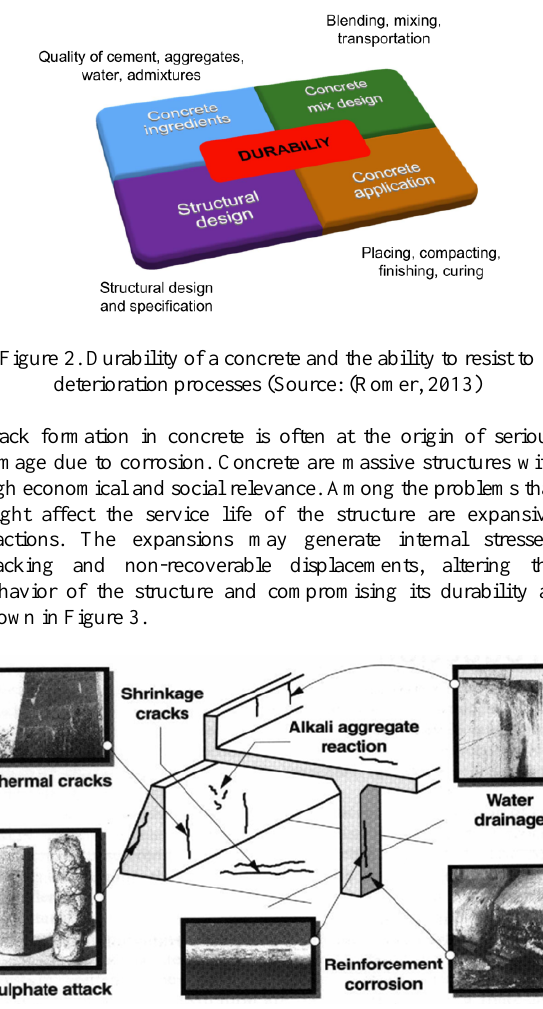
Figure 3. Deterioration in Concrete